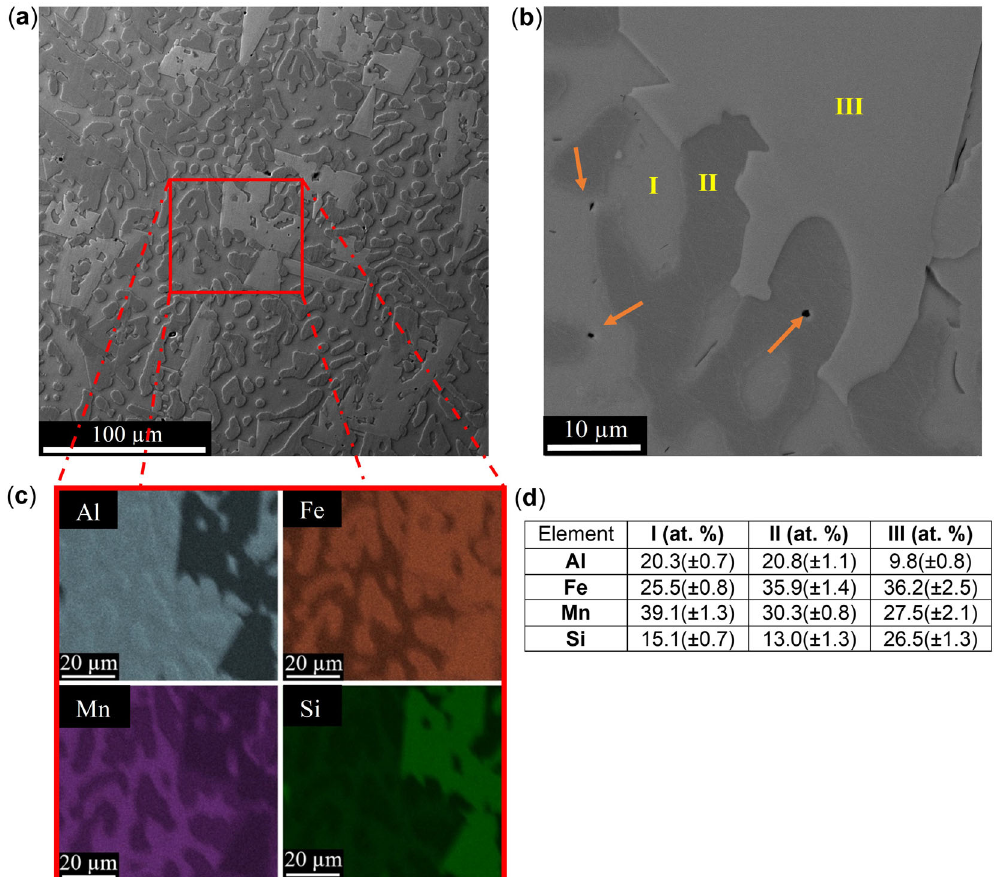
Fig. 1 Microstructure of the AlFeMnSi alloy. a Backscattered electron (BSE) scanning electron microscopy (SEM) image (20 kV accelerating voltage) of as-cast AlFeMnSi, b high-magni fi cation BSE image, c SEM energy-dispersive X-ray spectroscopy (EDXS) map corresponding to the highlighted region in a , and d table indicating measured elemental composition of all phases (I – III) in as-cast AlFeMnSi (based on EDXS point